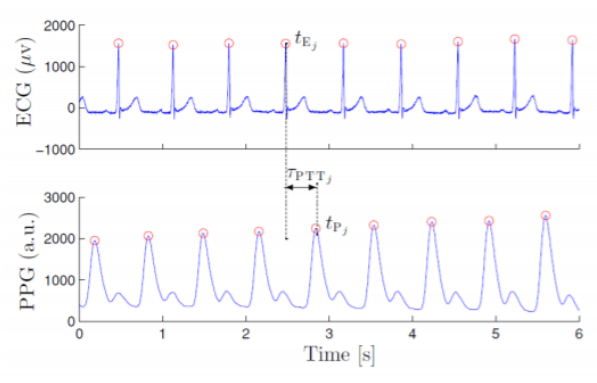
Figure 1. Comparison between ECG and PPG signals [11].